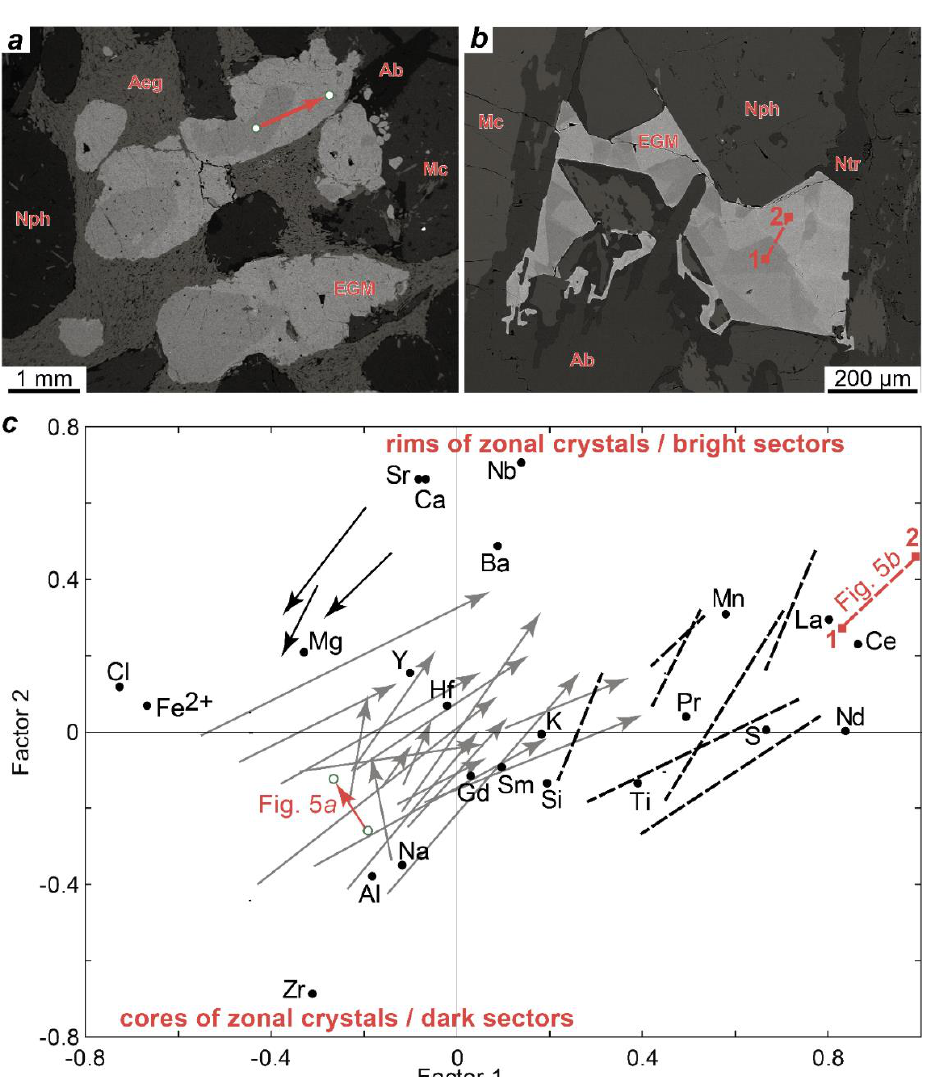
Figure 6. ( a ) BSE-image of the oscillatory zonal EGM grains from the ijolite LV-222-151; ( b ) BSE-image of the sector-zoned EGM grains from the foyaite LV-IV-3-5; ( c ) position of the points shown in Figure 6a (red arrow) and Figure 6b (red dotted line) in the coordinates of the Factor 1 vs Factor 2 (see the results of factor analysis in Figure 5). The gray arrows show some examples of the oscillatory zoning (the arrow is directed from the core to the rim) in the EGM from magmatic rocks. The black arrows show some examples of the oscillatory zoning (the arrow is directed from the core to the rim) in the EGM from metasomatized volcaniclastic rocks. Black dotted lines show some examples of the sector zoning in the EGM.